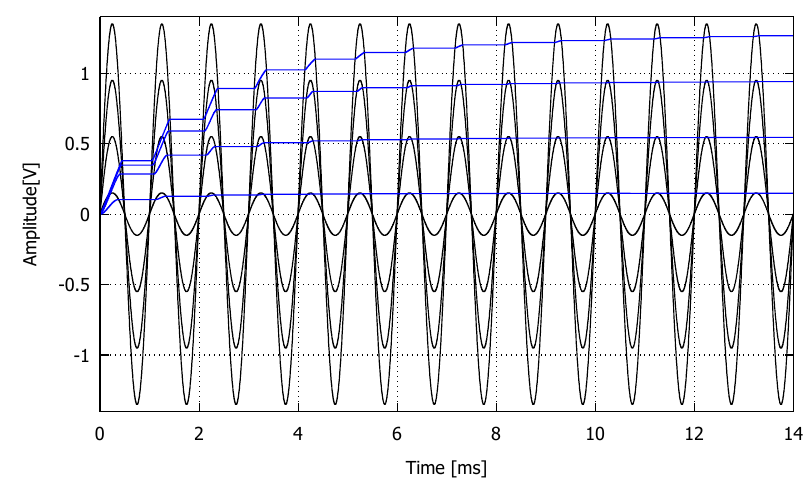
Figure 10. Peak detector transient